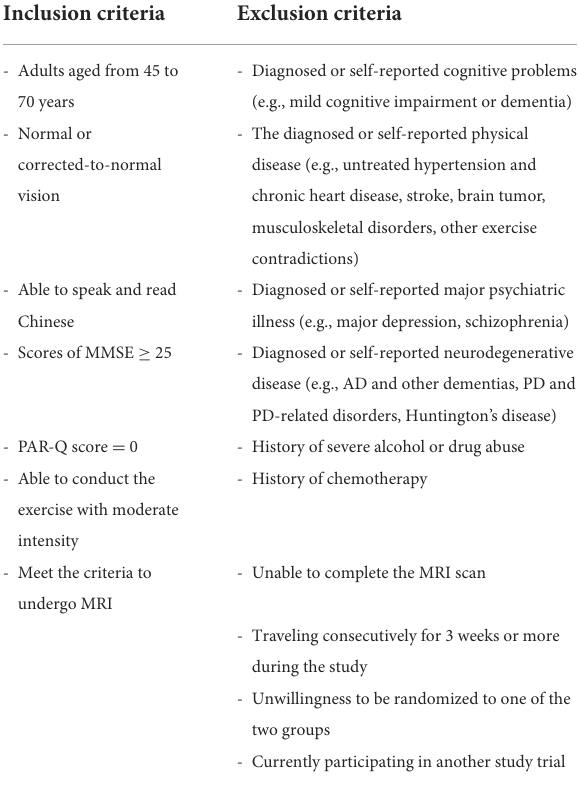
TABLE 1 Inclusion and exclusion criteria for participating in the